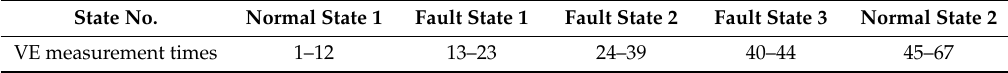
Table 1. Machine tool states and corresponding measurement times (or cycles).